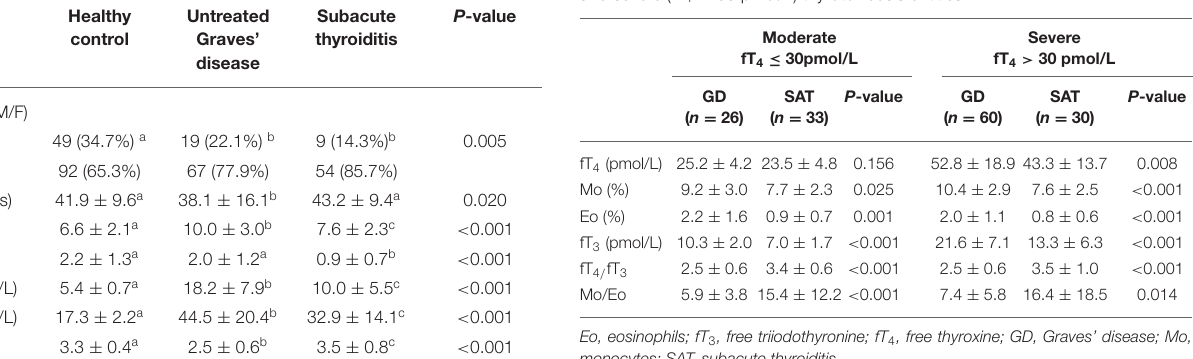
TABLE 2 | Comparison of GD and SAT patients in moderate (fT 4 ≤ 30 pmol/L) and severe (fT 4 > 30 pmol/L) thyrotoxicosis